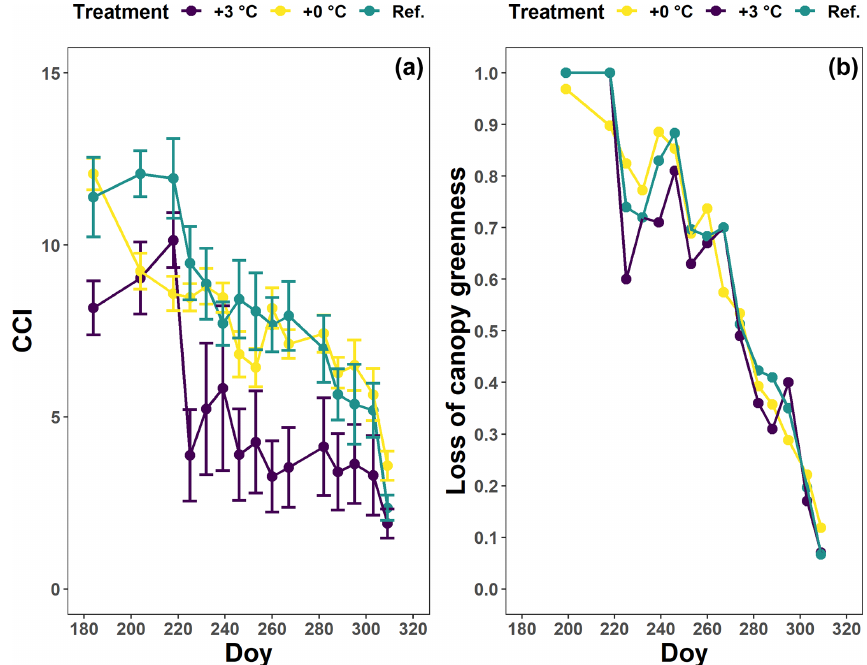
Figure A2. The chlorophyll content index (CCI; a ) and loss of canopy greenness (b) of the Fagus sylvatica saplings at the Drie Eiken Campus in Wilrijk for which no breakpoint could be calculated. The dots and error bars represent the mean CCI (a) and mean loss of canopy greenness (b) with standard errors. The colors represent the CCI or the loss of canopy greenness of the beech saplings in the reference plots (green; Ref.), the glasshouses that followed the outside ambient air temperature (yellow; + 0 ◦ C) and the glasshouses that were 3 ◦ C warmer than the outside ambient air temperature (purple; + 3 ◦ C).